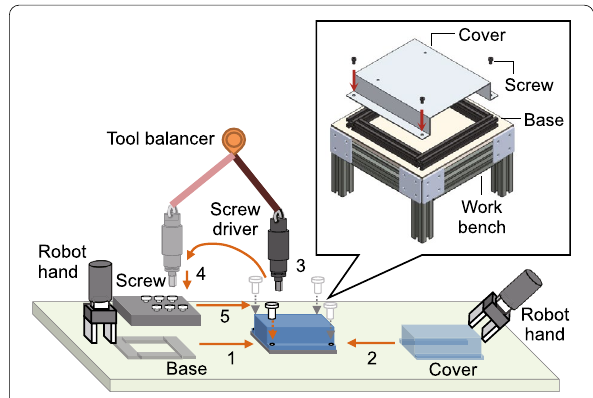
Fig. 3 Assembly tasks in atypical environment. Each part and tool are randomly placed